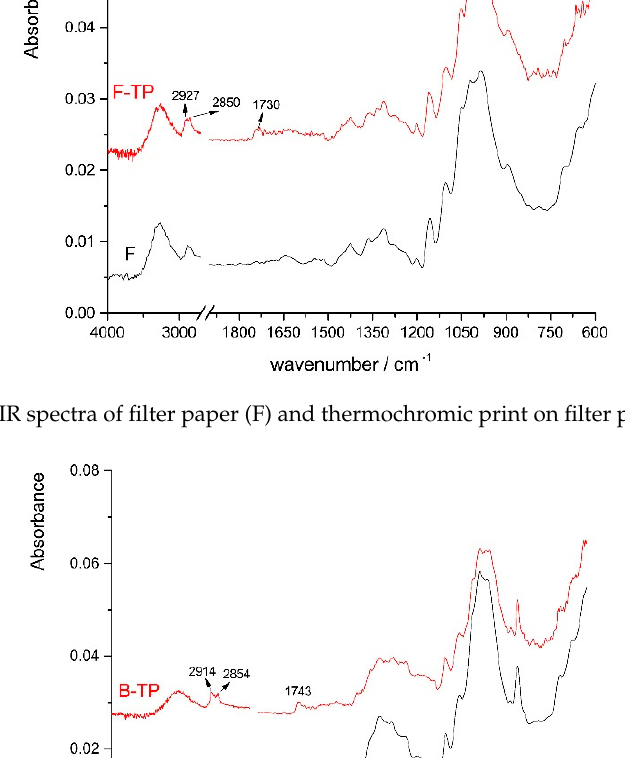
Figure 10. FTIR spectra of recycled paper (R) and thermochromic print on recycled paper (R-TP). 3.9. Surface Free Energies of Prints and the Interfacial Free Energies Table 7 shows the values of surface free energies and surface free energy components of thermochromic prints. All surface free energy values of the prints are greater than the surface free energy of unprinted papers (Table 4), except in the case of F paper. In addition, the dispersion components of all prints are higher compared to dispersion components of unprinted paper surfaces. The polar component of F-TP print is considerably smaller than the polar component of the surface